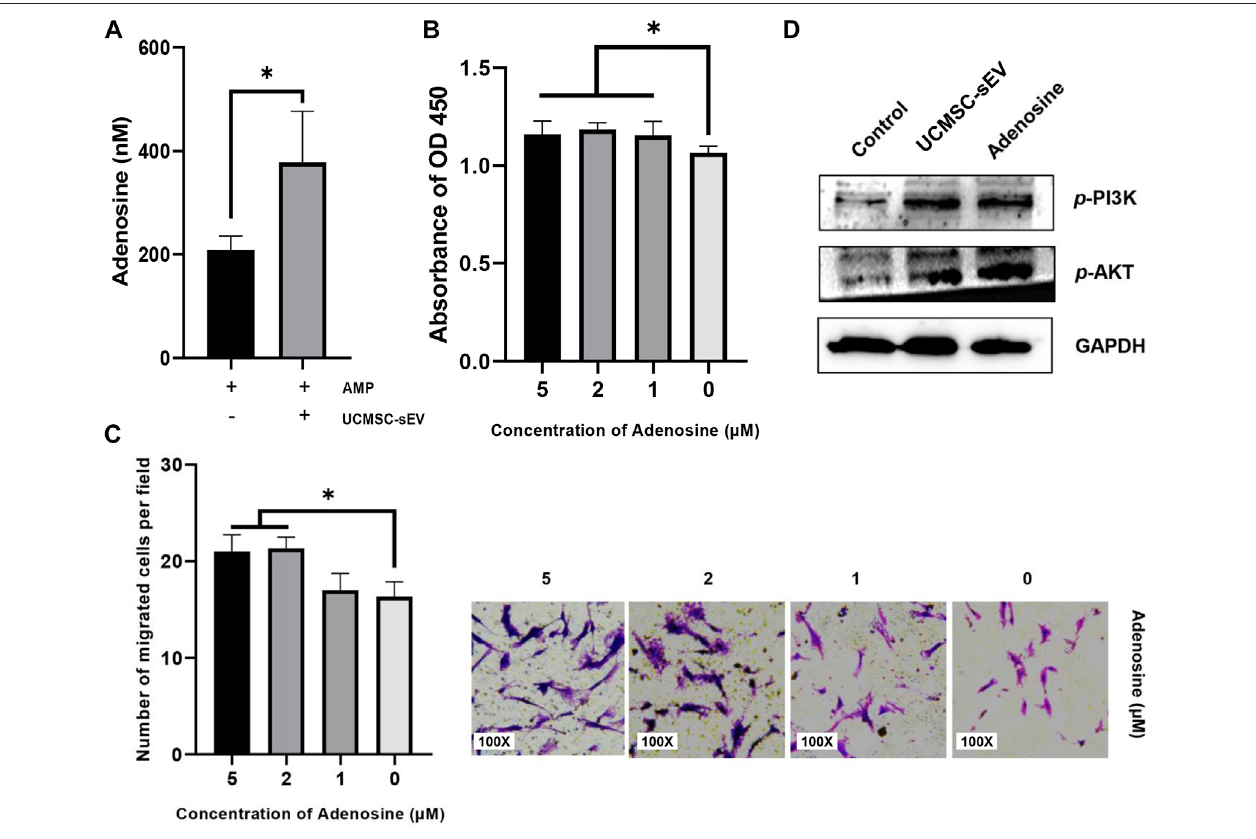
FIGURE 4 | The sEV CD73 catalyzes the production of adenosine and activates the PI3K/AKT pathway to promote proliferation and migration. (A) UCMSC-sEV use exogenous 5 ′ AMP to produce adenosine through surface CD73. (B) CCK-8 and Transwell assay results (C) show that the addition of exogenous adenosine signi fi cantly promotes the proliferation and migration of PUSMCs in vitro . (D) Western blot detection of the expression levels of PI3K/AKT in PUSMCs.